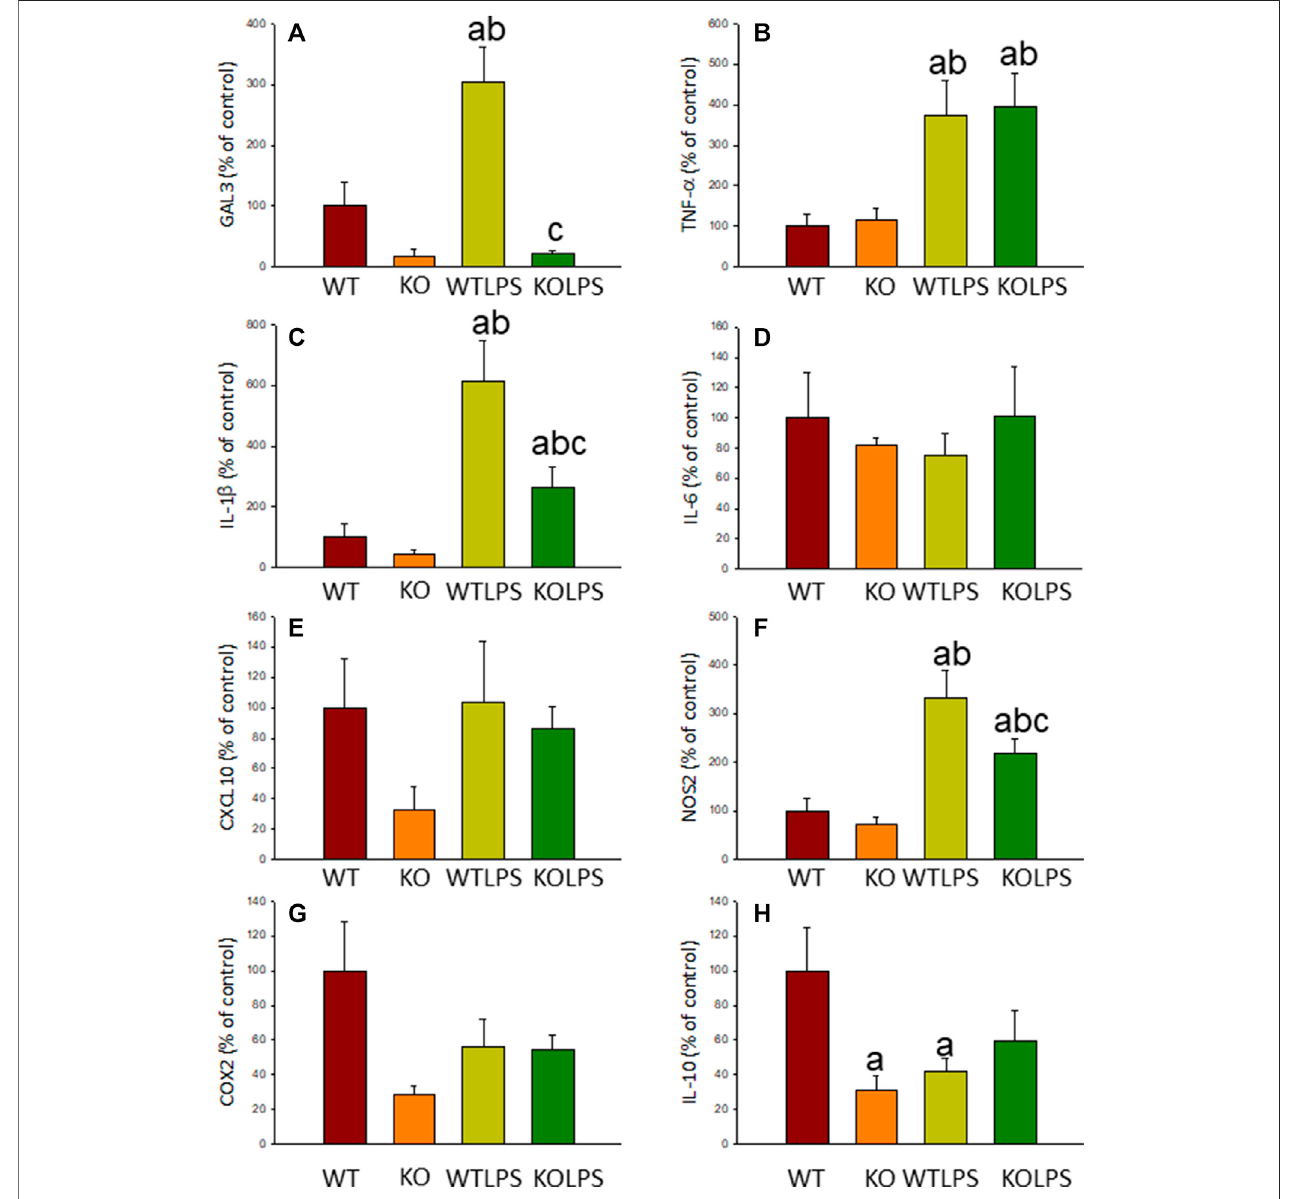
FIGURE 6 | Effect of the LPS treatment on the expression levels of Gal3, TNF- α , IL-1 β , IL-6, CXCL10, NOS2, COX2 and IL-10 in SN. Measurement of the effect of the treatment with LPS on the expression levels of mRNA of Gal3 (A) , pro-in fl ammatory mediators such as TNF- α (B) , IL-1 β (C) , IL-6 (D) , CXCL10 (E) , NOS2 (F) , COX2 (G) and the anti-in fl ammatory mediator IL-10 (H) in the SN of mice from the different experimental groups by using RT-qPCR. Results are mean ± SD of at least threemiceperexperimentalgroup,normalizedto β -actinandexpressedaspercentagerelativetotheWTgroup.Statisticalsigni fi cance:One-wayANOVAfollowed bythe Fisher ’ sLSD post hoctest formultiple comparisons wasused,with α (cid:2) 0.05: (a) ,compared withtheWT group; (b) , compared withtheKO group; (c) , compared with the WTLPS group; p < 0.05. Abbreviations: WT, wild type mice; WTLPS, wild type mice treated with LPS; KO, Gal3 knockout mice; KOLPS, Gal3 knockout mice treated with